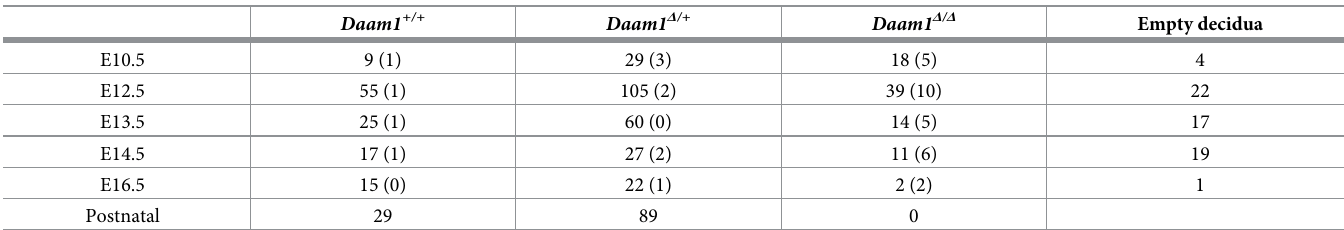
Table 1. Number of Daam1 +/+ , Daam1 Δ /+ , and Daam1 Δ / Δ for each developmental stage.